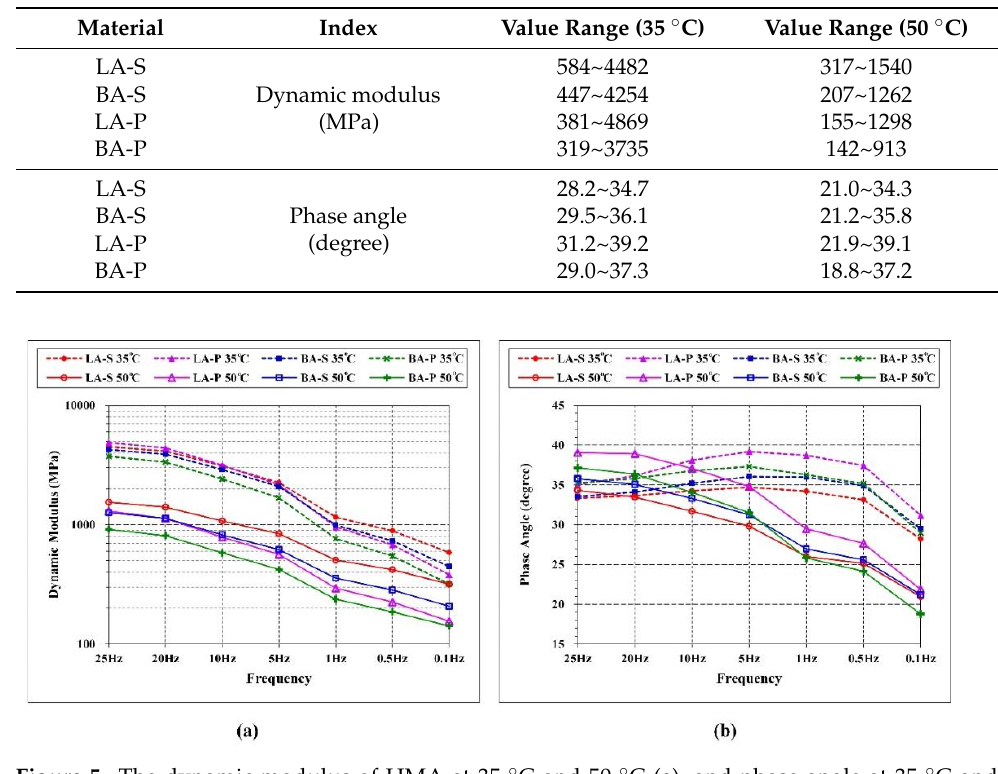
Figure 5. The dynamic modulus of HMA at 35 °C and 50 °C ( a ), and phase angle at 35 °C and 50 °C ( b ).